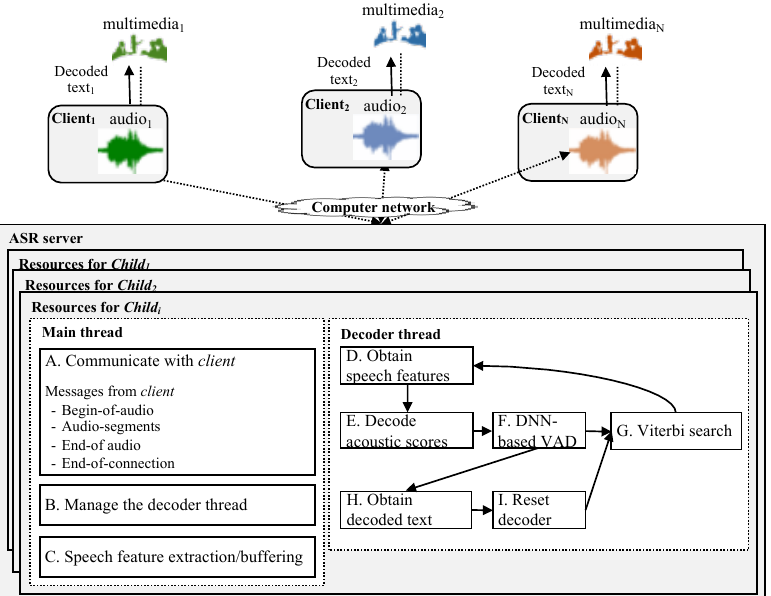
Figure 1. Overall structure of the server-client-based online automatic speech recognition (ASR) system used in this